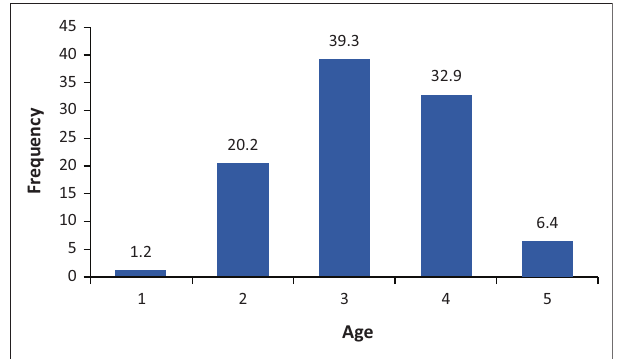
FIGURE 1: Repartition of tuberculosis suspected animals by age.